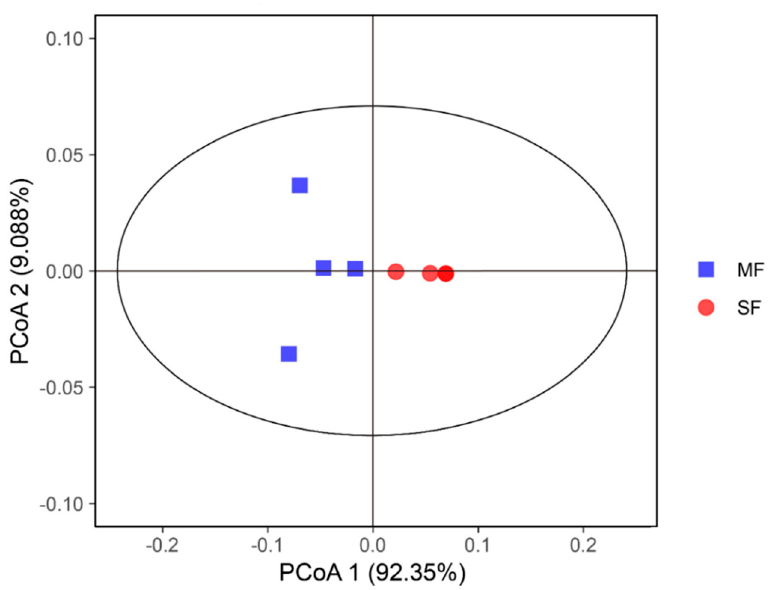
Figure 1. Principal coordinate analysis of microflora in fermented feed samples.